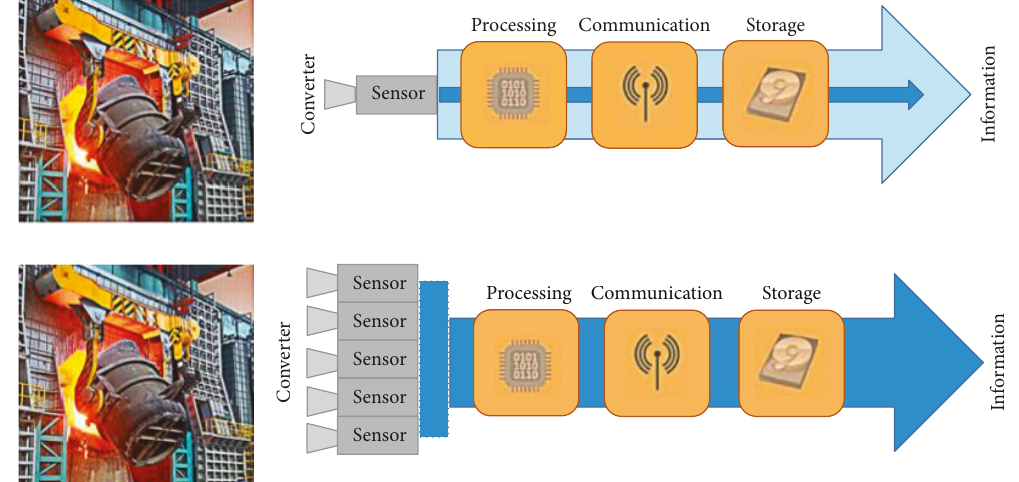
Figure 1: The performance bottleneck of signal